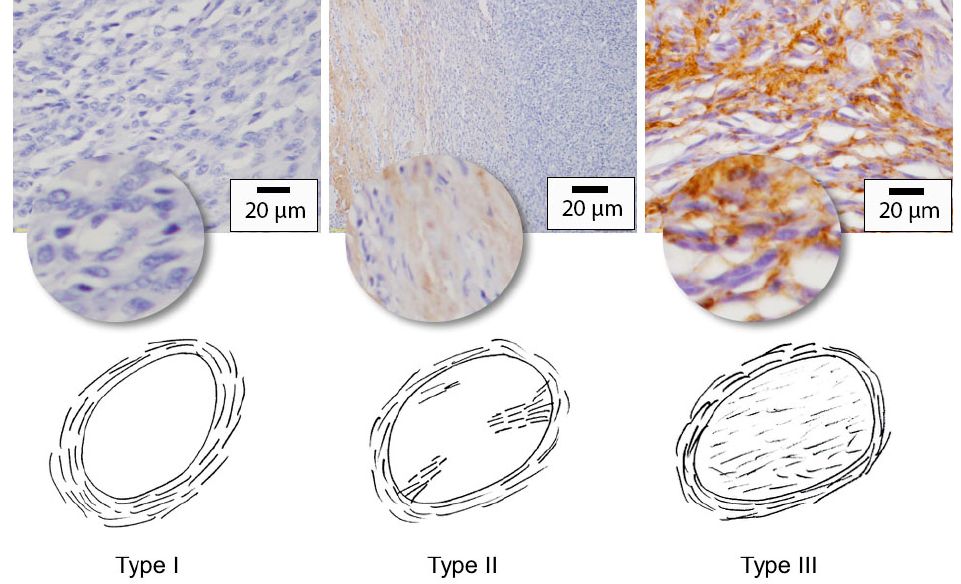
Figure 2. Grading scale for decorin immunostaining distribution pattern. Decorin immunostaining is typically observed within the stromal surrounding the cells. A type 1 pattern was assigned when decorin immunostaining was confined to the peri-tumoural capsule only and no staining was visible within the tumour itself. A type 2 pattern was applied to cases where isolated islands of immunostained stromal tissue penetrated the tumour at various locations. For a type 3 pattern, intensely staining decorin-labelled stroma saturated the entire tumour and intertwined closely about individual cells (main images: 40 × objective; inset images are unscaled digital enlargements for illustrative